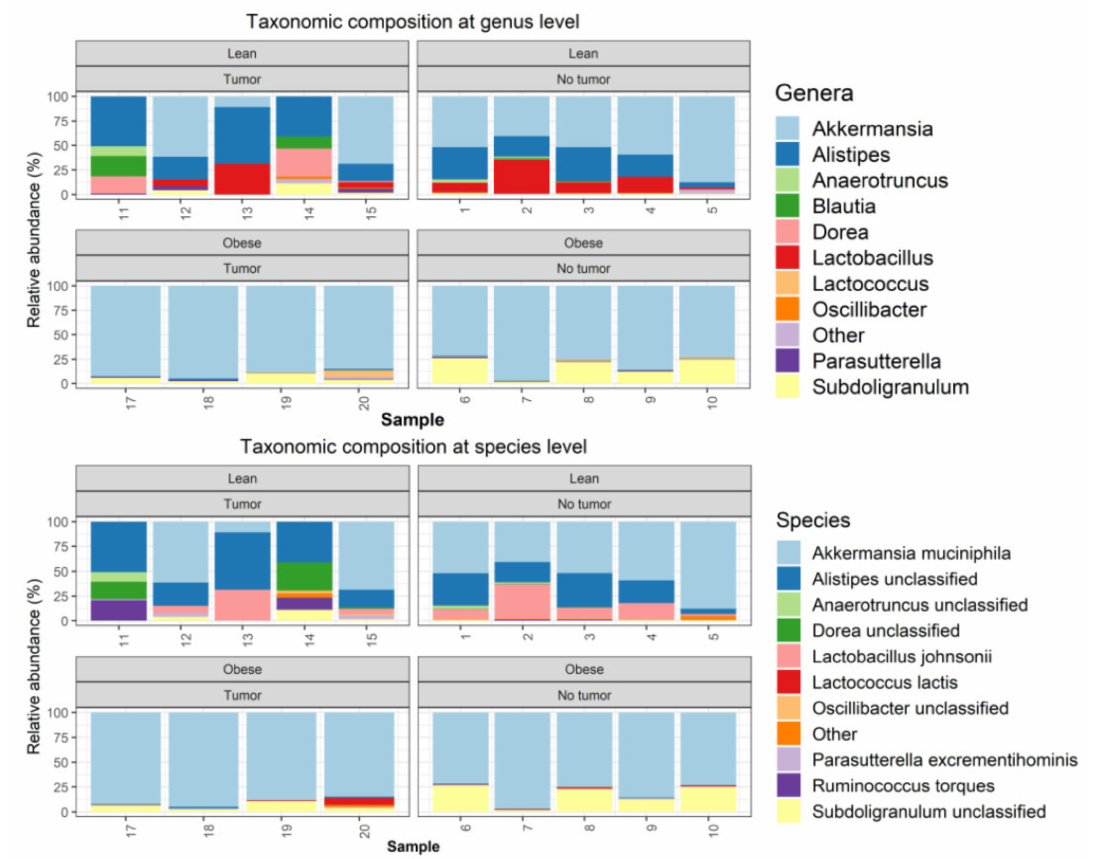
Figure 3. Metagenomics analysis of taxonomic composition at the genus and species level.